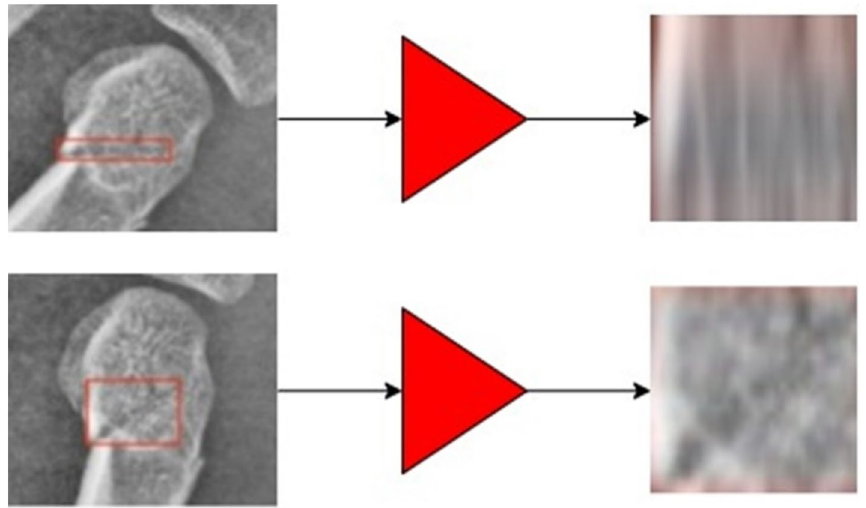
Figure 6. Feature ambiguity in fracture detection. When the fracture line was lying horizontally (upper left), a narrow rectangle box was annotated, and when the fracture line was in an oblique direction, a broader box was annotated (lower left). Both boxes were fed into the RoI-Align operator and resized to the same square shape (right). Processing with the RoI-Align operator caused ambiguity of the image and downgrade the model